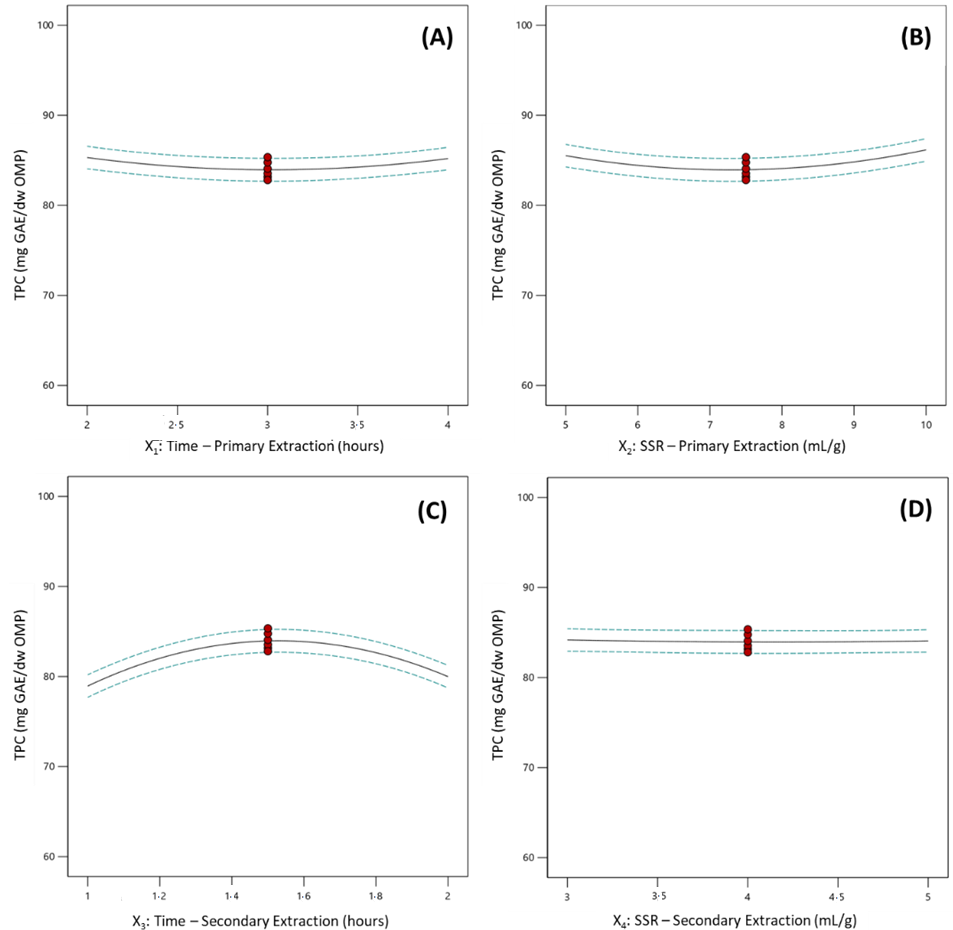
Figure 3. One variable plots portraying the effect of each process variable on the total phenolic con- tent of the extracts obtained from olive mill pomace samples (( A ) — effect of the time of the primary extraction; ( B ) — effect of the solvent-to-sample ratio during the primary extraction; ( C ) — effect of the time of the secondary extraction; ( D ) — effect of the solvent-to-sample ratio during the secondary extraction; represent design points; represent 95% confident interval band).